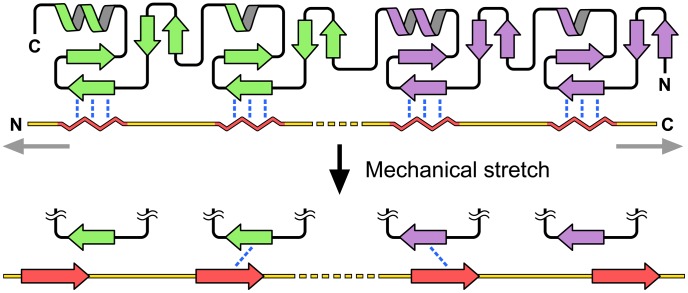
LIM pair binding peptides and spacer regions.Simple hypothetical model of a LIM domain pair (shown in green and purple ribbon diagram) bound to CasSD shown in yellow with its secondary structural elements colored in red. Wavy red lines and red arrows represent PPII helices and β-strands, respectively. Hydrogen bonds between LIM domains and CasSD are depicted in blue dotted lines. Mechanical stretching force is represented by gray arrows.